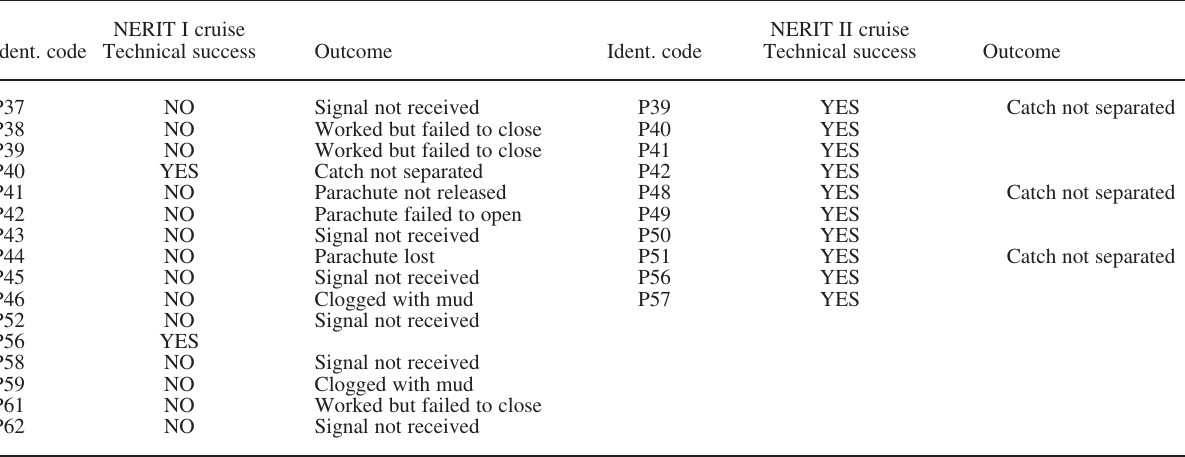
algorithm after ln (n+1) data transformation (Lleonart and Roel, 1984; Pennington,